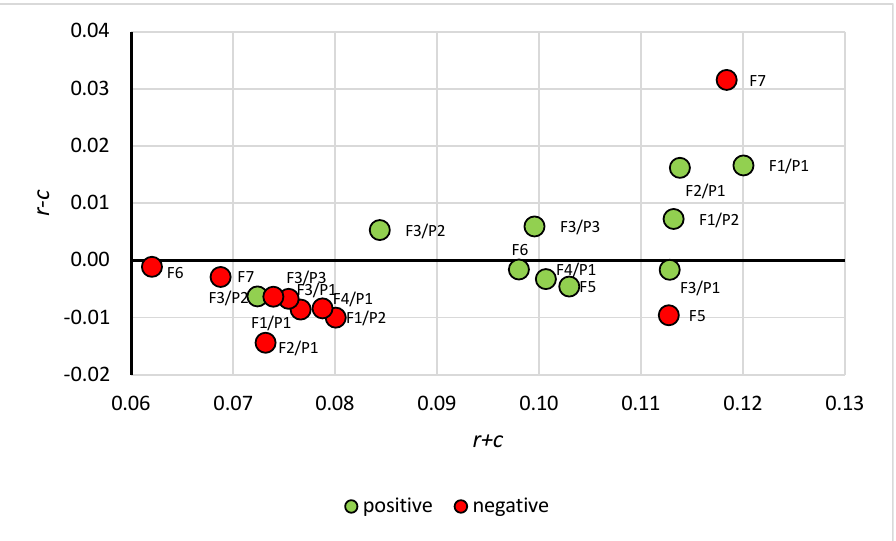
Figure 18. Influence map for criteria.